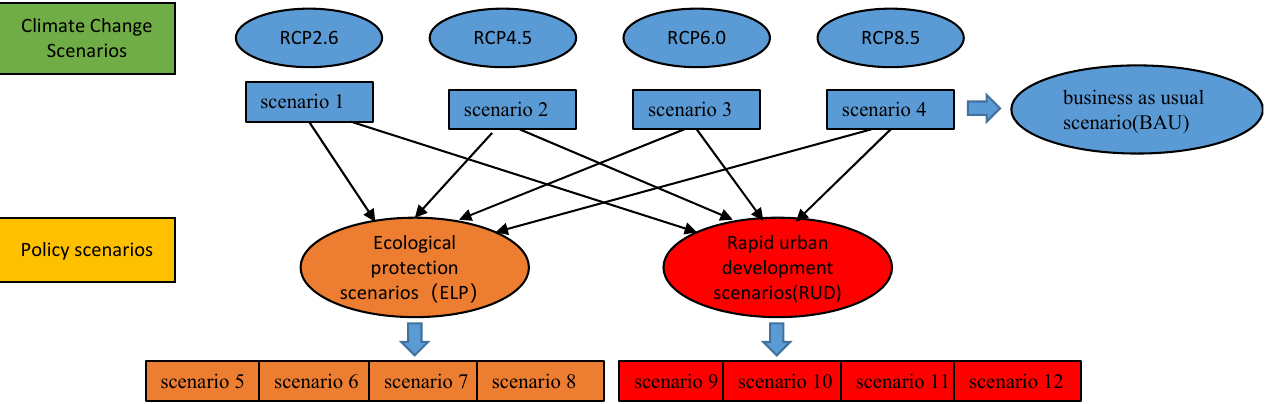
Figure 2. Flowchart of land use scenario setting.